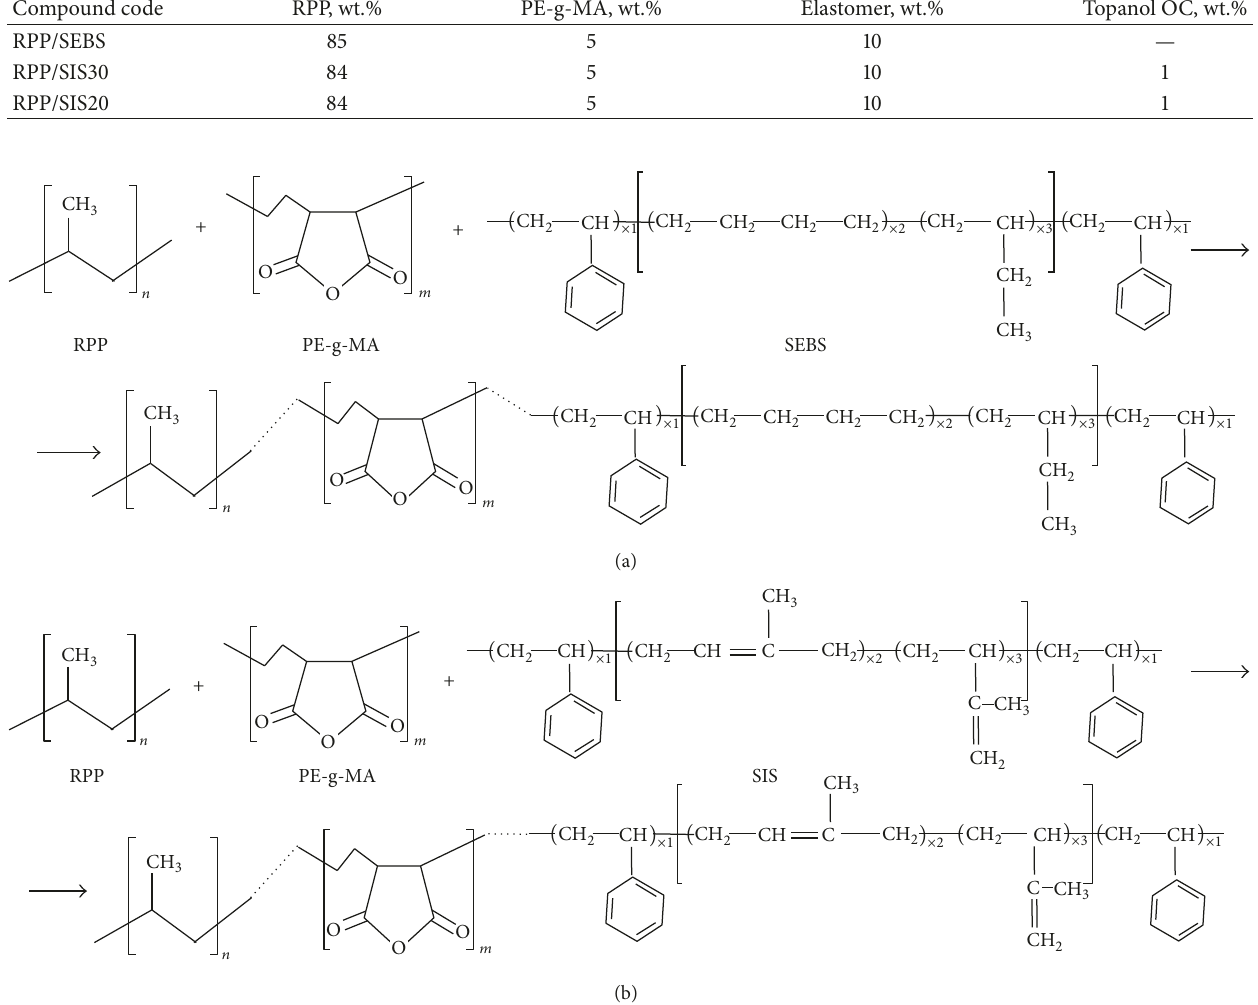
Figure 1: Proposed mechanism for compatibilizing action of PE-gMA in RPP compounds. (a) RPP/SEBS compound; (b) RPP/SIS